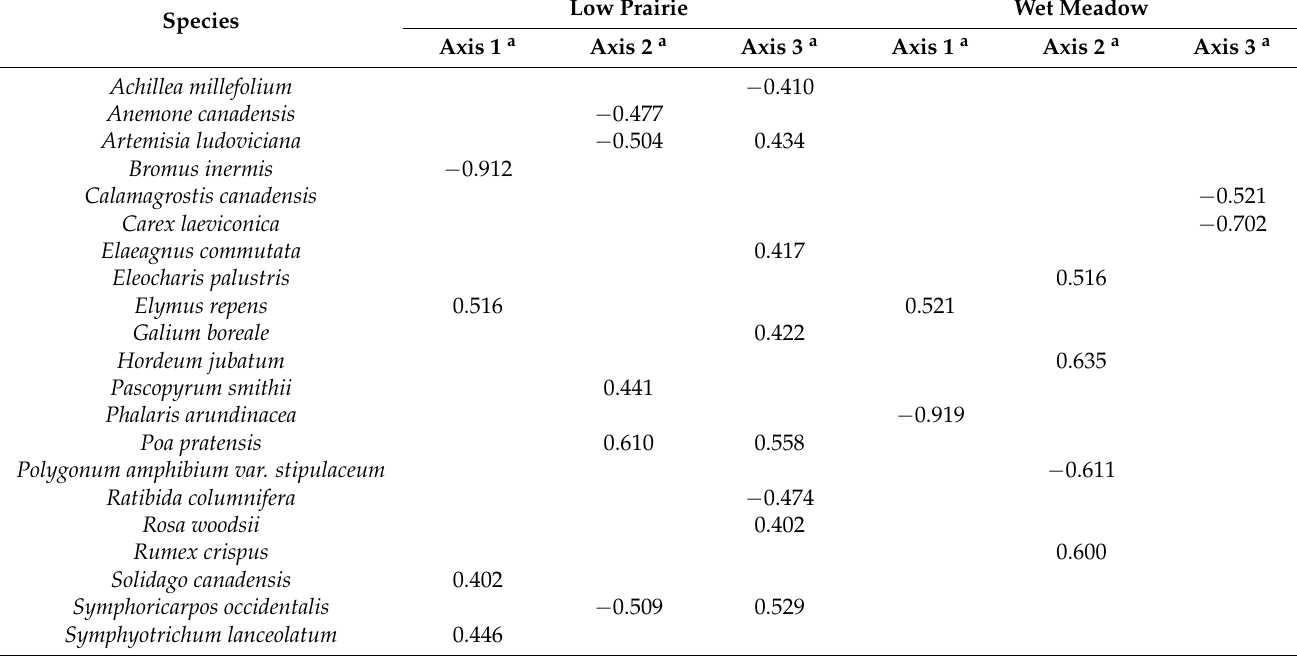
a Pearson correlation with NMS